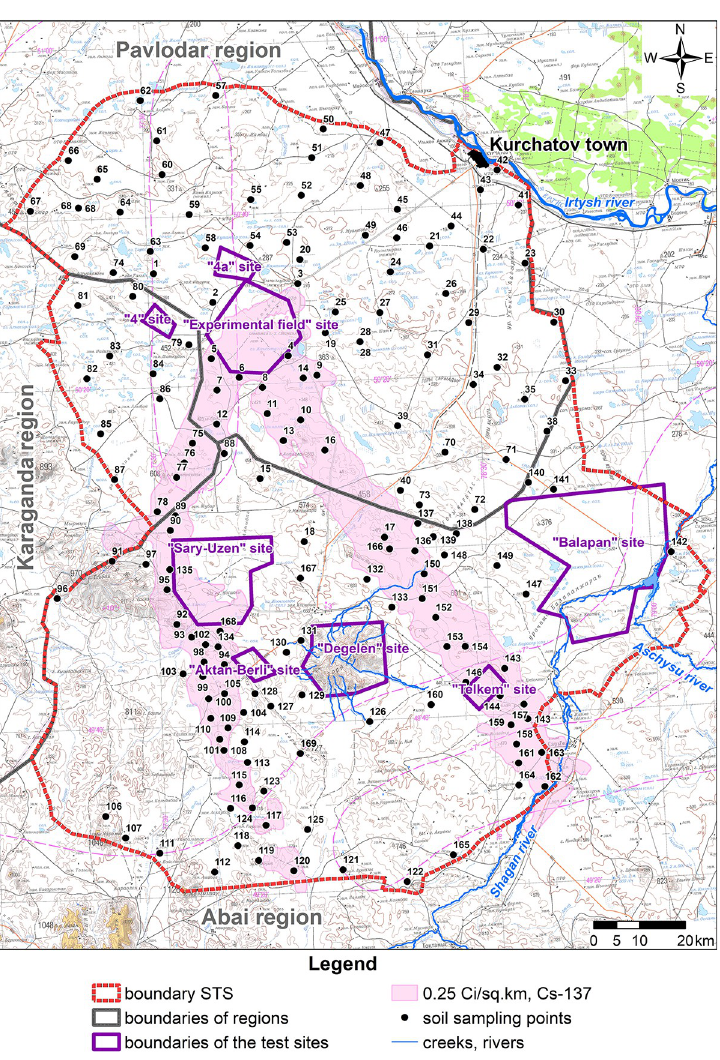
Fig 2. Schematic site preparation for layer-by-layer soil sampling within STS with fallout overlaid in the form of plumes (along the 0.25 Ci/km 2 isoline for 137 Cs).